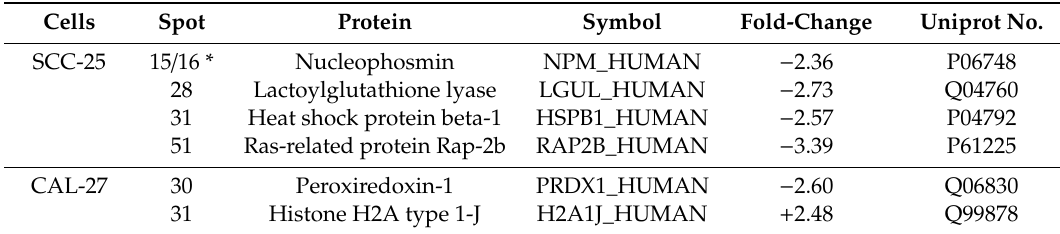
Table 5. Proteins modified by vitamin D treatment of head and neck cancer cell lines.